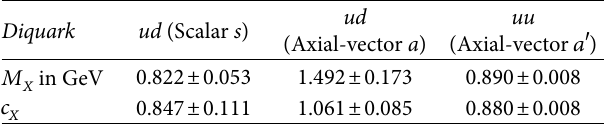
and couplings 𝑐 for the scalar– 𝑋 𝑋